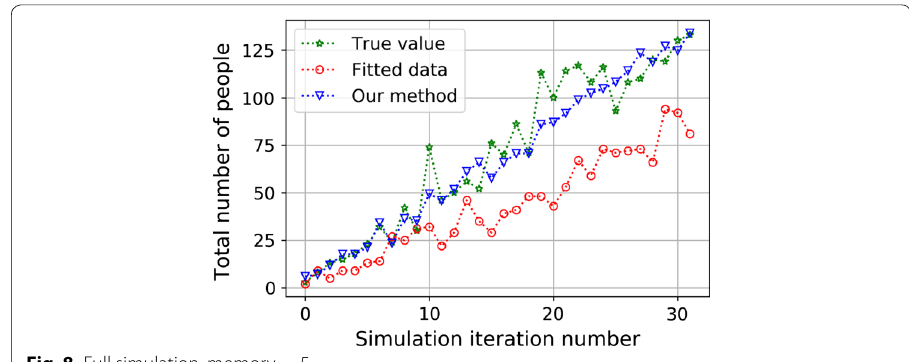
Fig. 8 Full simulation, memory = 5